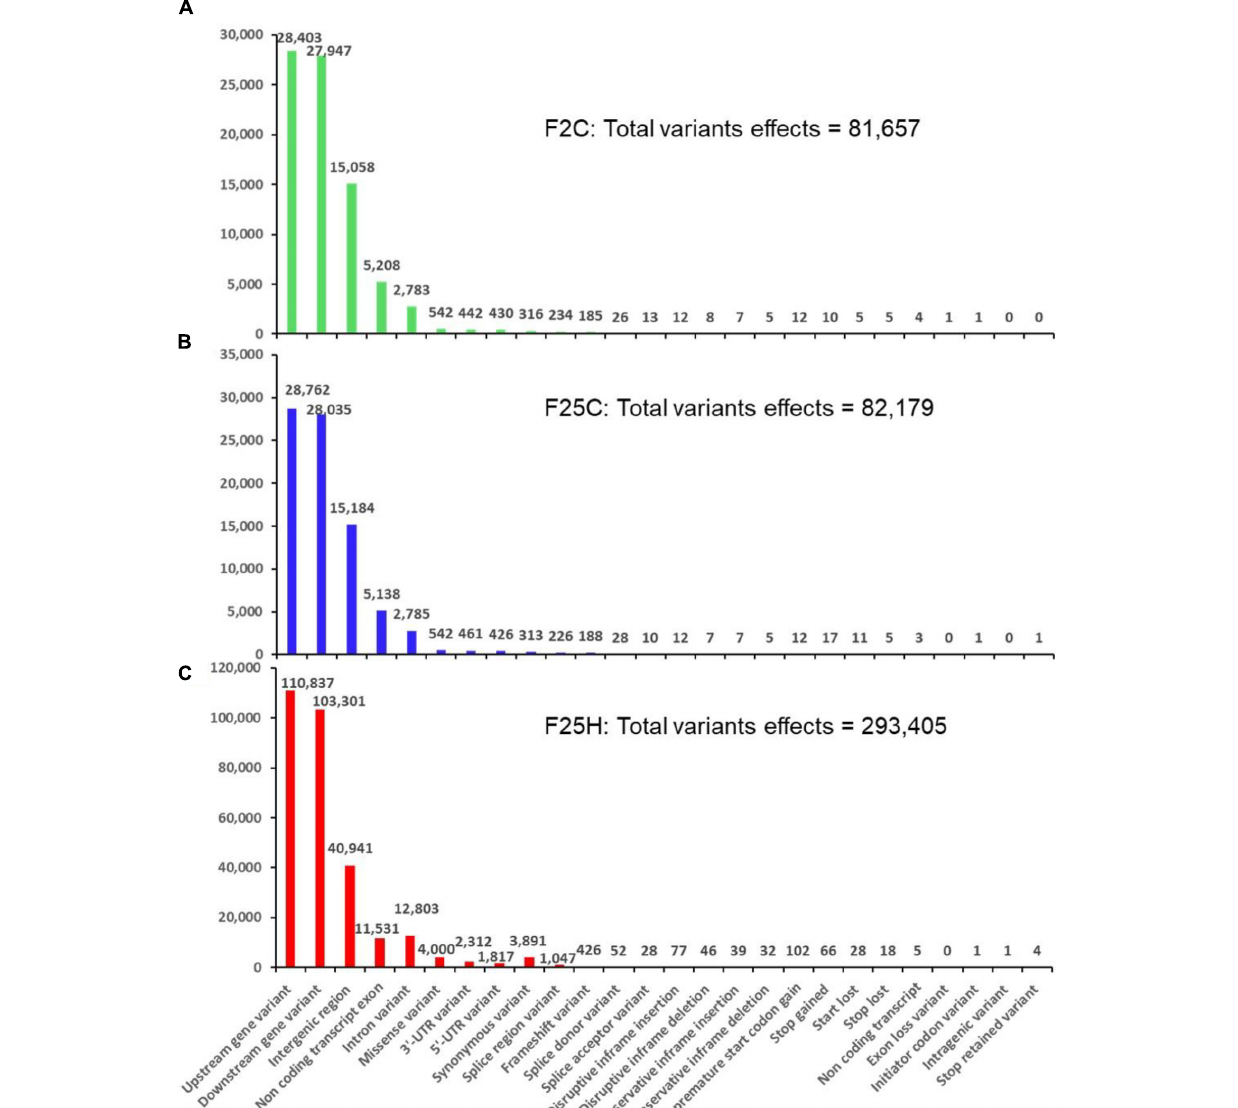
percentage of methylation in the CG, CHG, and CHH contexts ( Supplementary Figures 2–4